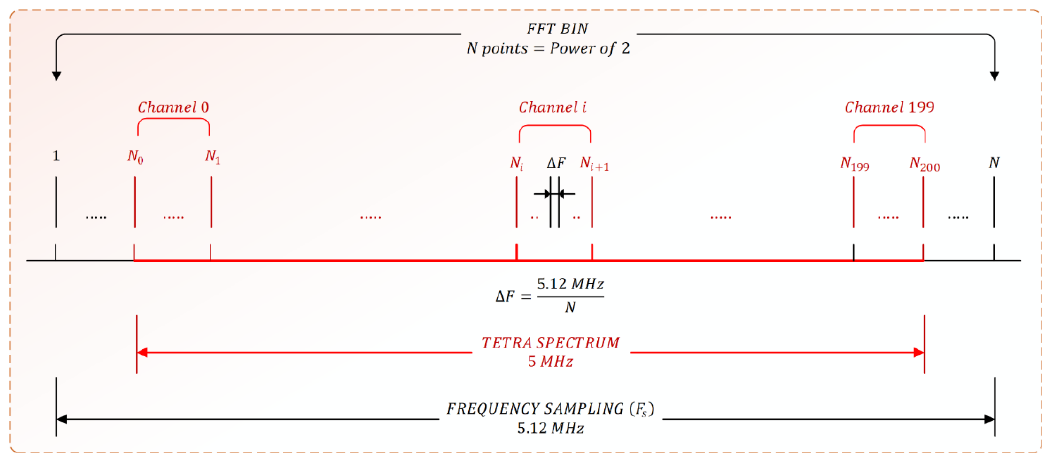
Figure 2. Correspondence between the spectral lines obtained after applying FFT and the TETRA channels.